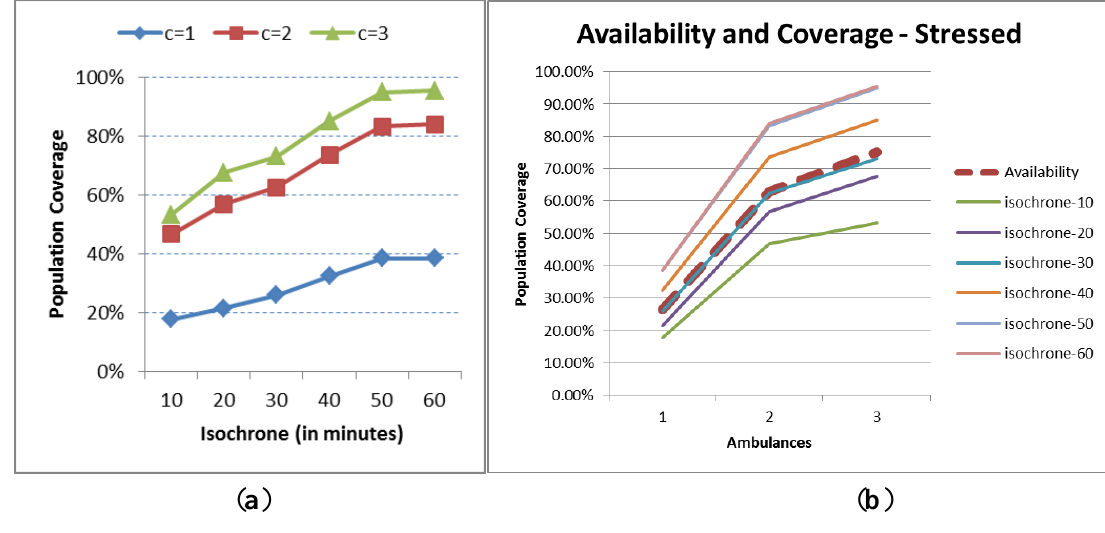
Figure 12. Population coverage for the stress scenario ( a ) Population coverage; ( b )